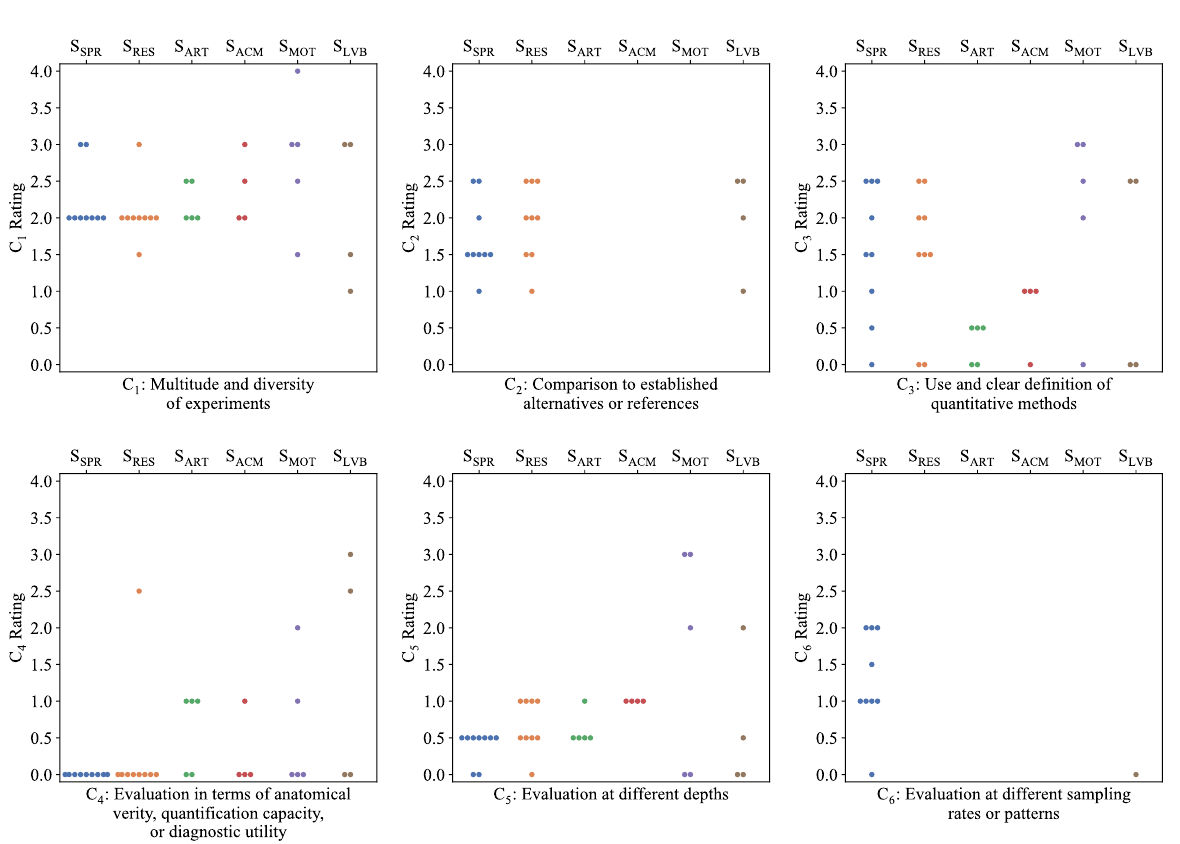
Figure 8. Visual overview of the individual ratings for the human-involving experiments covering all criteria, subgroups, and studies. In case of criteria not applicable to certain subgroups, the corresponding space is left blank. The rating scale is as follows: 0: absent, 1: lacking, 2: adequate, 3: ample, 4: thorough. The points corresponding to different subgroups have been assigned unique colors to facilitate their visual identification.